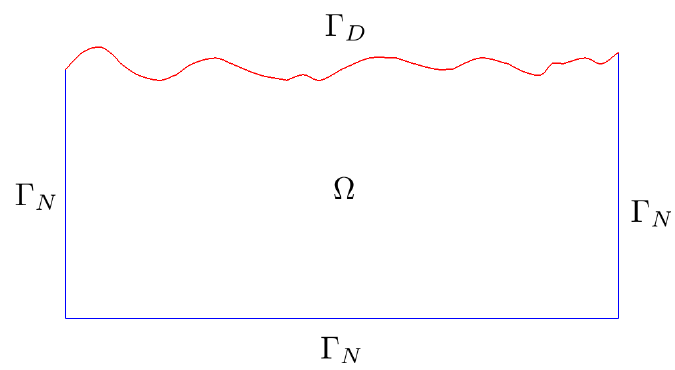
Figure 1. Computational domain Ω with rough boundaries on the